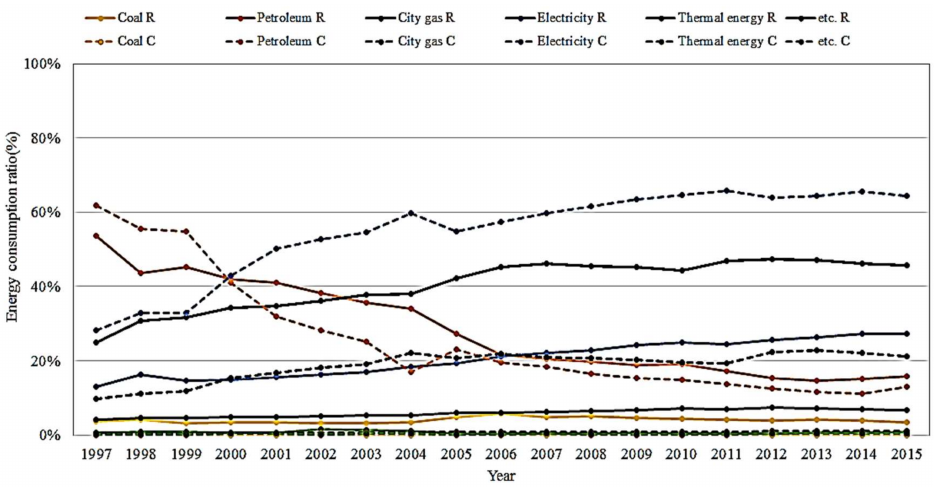
Figure 5. Comparison of residential and commercial greenhouse gas emission.